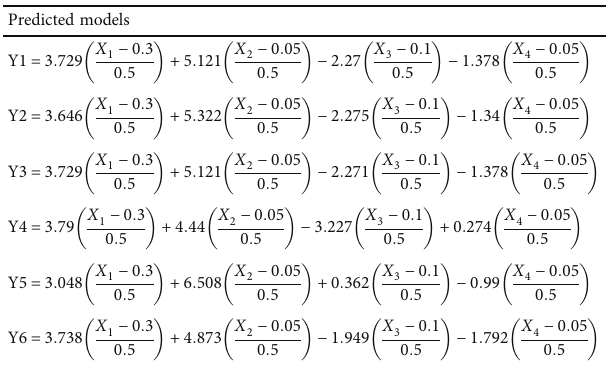
Table 3: Predicted models of the responses (color (Y1), taste (Y2), fl avor (Y3), texture (Y4), aroma (Y5), and overall acceptability (Y6)). Predicted models